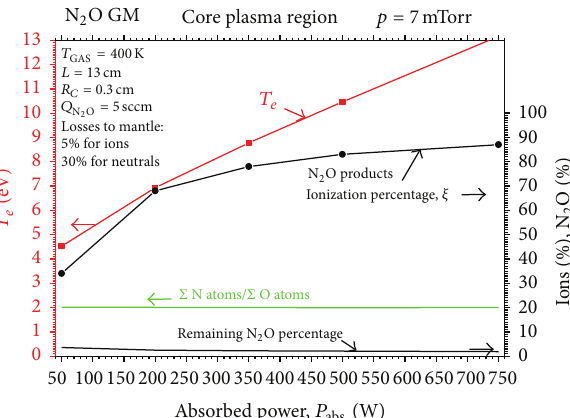
Figure 9: As in Figure 8 but for 𝑇 𝑒 , ionization percentage, and N 2 O remaining percentage.